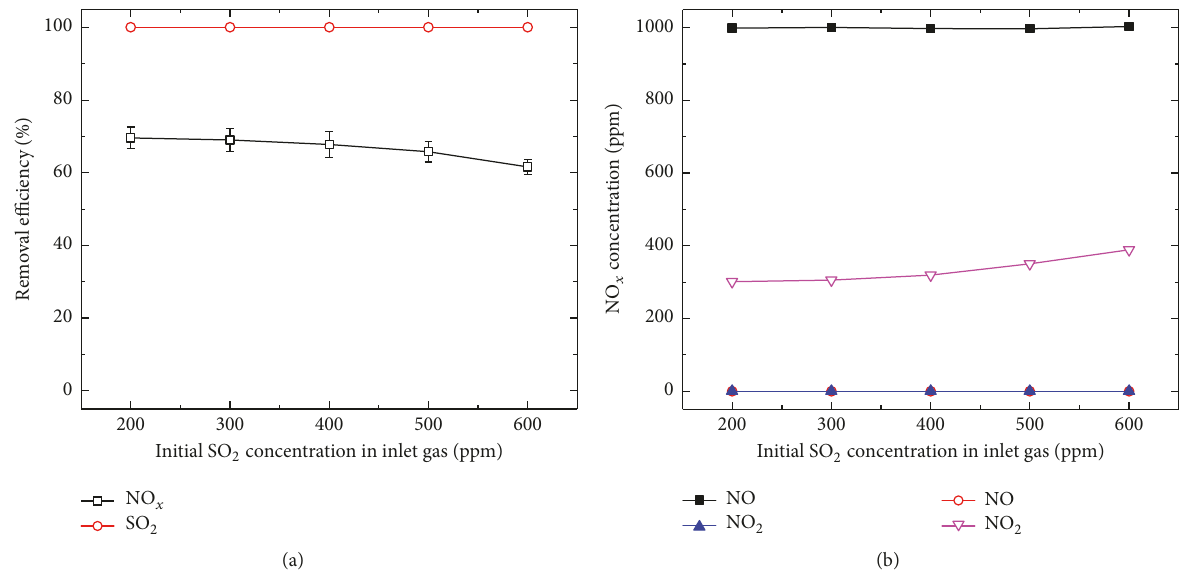
Figure 13: The change of (a) NO inlet SO 2 concentration is 200–600 ppm, inlet NO solution temperature is 293 K; solid points refer to inlet NO